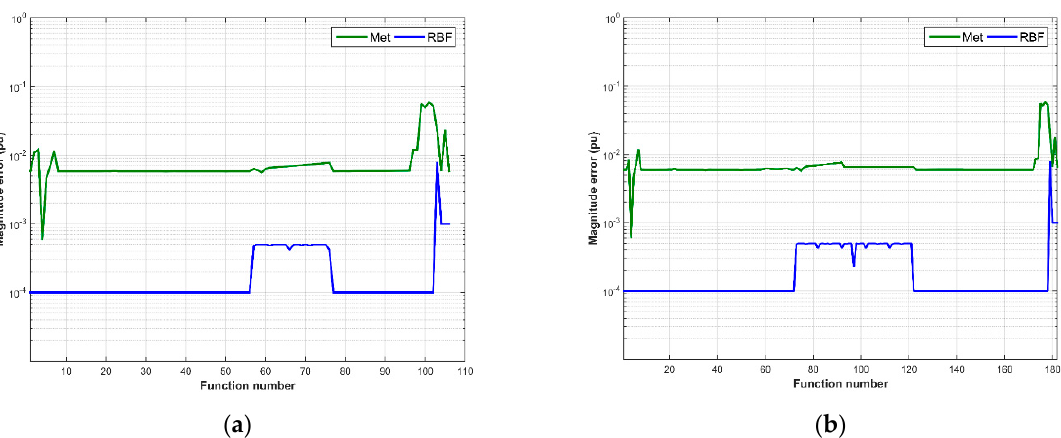
Figure 7. The magnitude error graphs for subsequent functions: ( a ) data for the P class of the PMU device; ( b ) data for the M class of the PMU device.